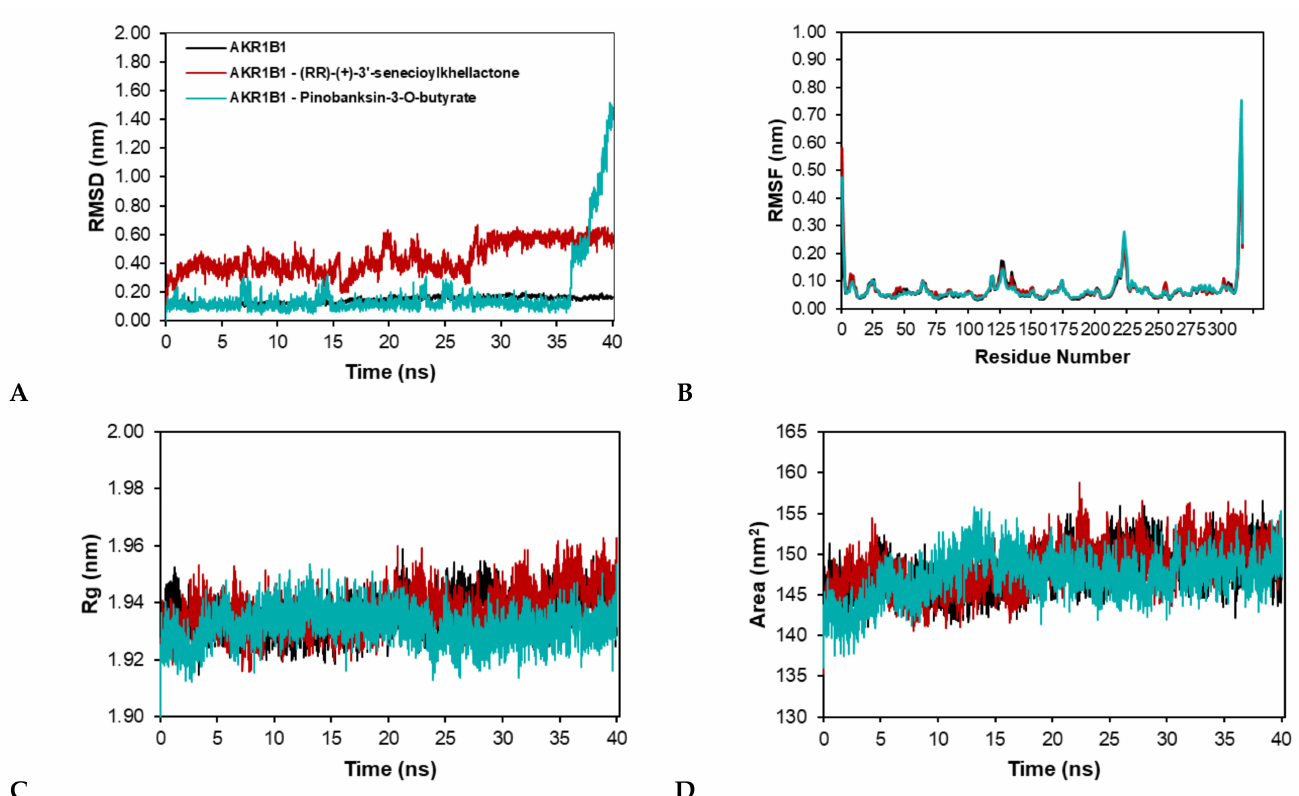
Figure 5. Molecular dynamic simulation trajectory analysis of AKR1B1, and AKR1B1-ligand com- plexes during 40 ns simulation. ( A ) RMSD of backbone atoms for AKR1B1-ligand complex. ( B ) RMSF of C α AKR1B1-ligand complex. ( C ) The radius of gyration (Rg) of backbone atoms. ( D ) SASA of AKR1B1-ligand